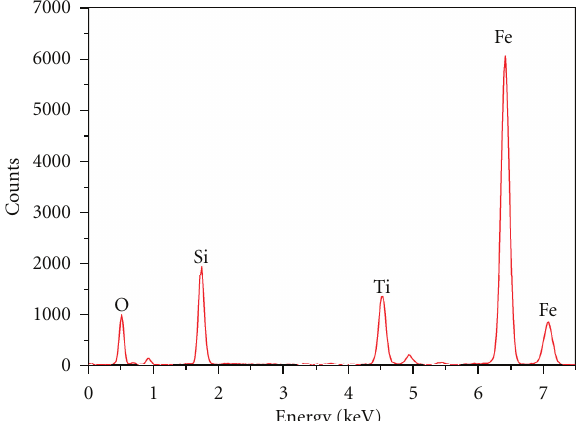
Figure 5: EDS pattern of Fe 3 O 4 /SiO 2 /TiO 2 composites calcined at 500 ◦ C for 2h.